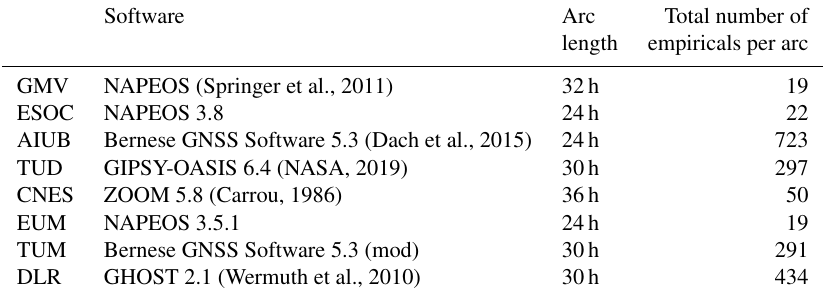
Table 1. Main characteristics of the individual solutions (GMV,